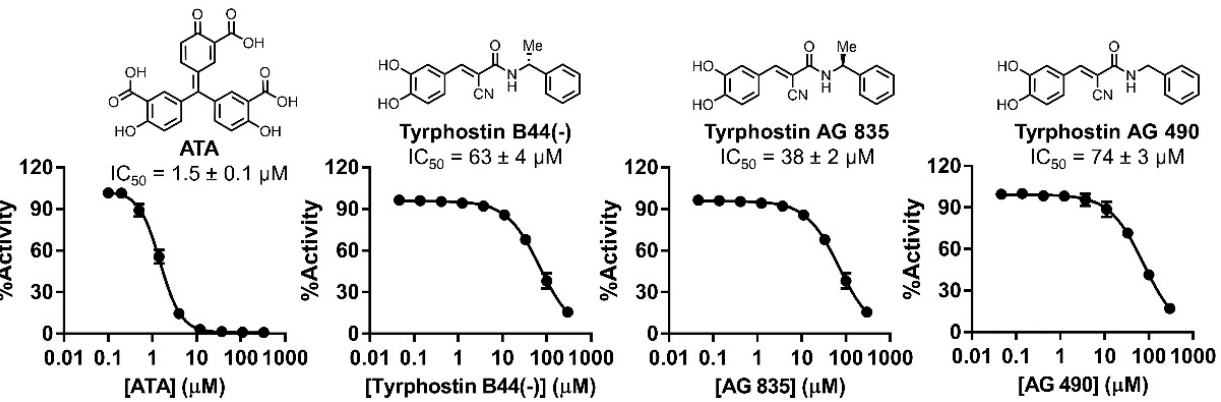
Figure 6. Fluorescence IC 50 characterization of selected hits and analogs from the LOPAC pilot screen ( n = 2).